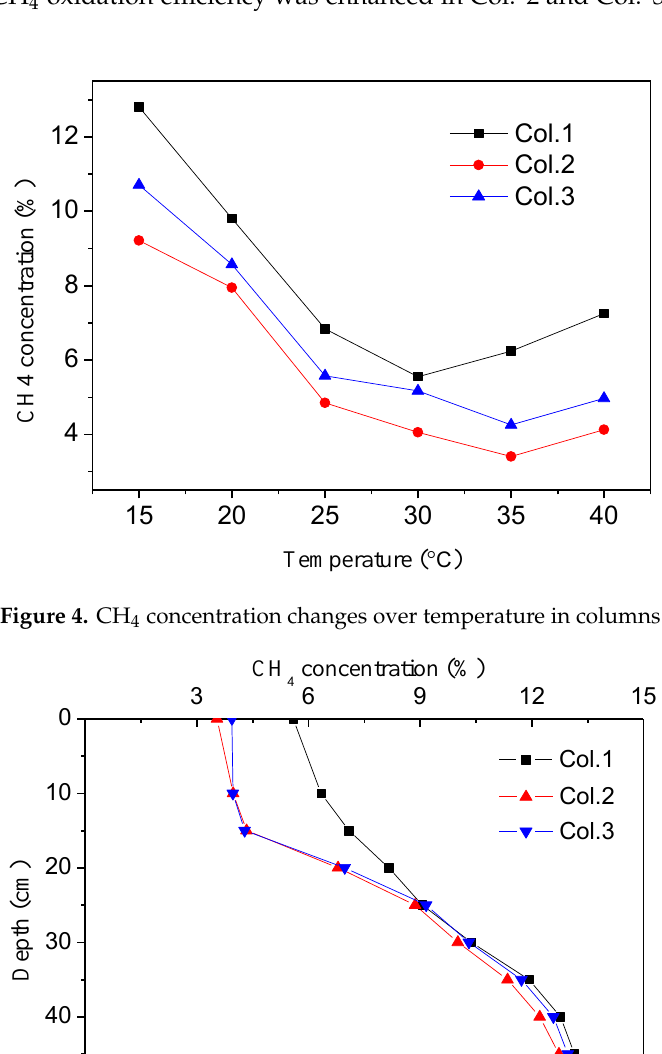
Figure 4. CH 4 concentration changes over temperature in columns.